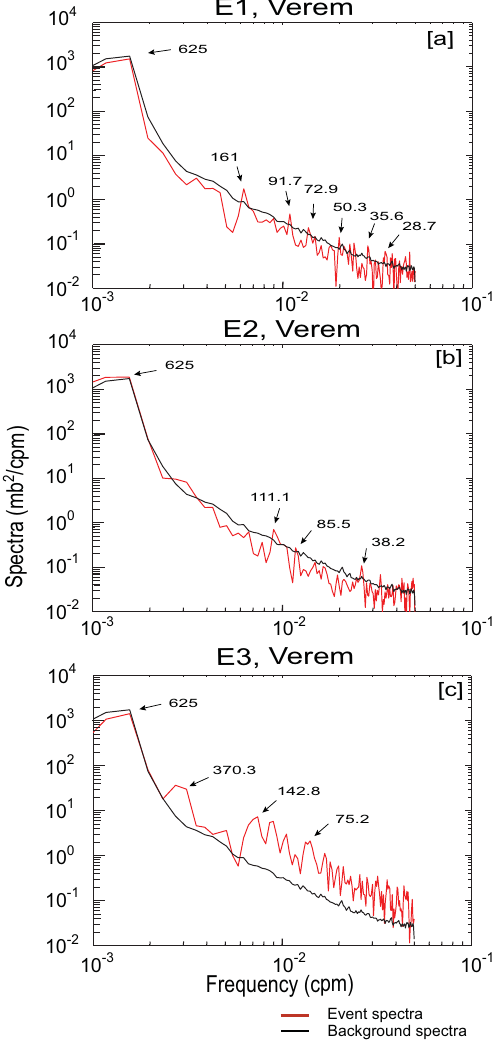
Fig. 7. Atmospheric pressure anomaly spectra during differ- ent events (red) along with the corresponding background spectra (black) at Verem (a) E1 over 3 days (Julian days 174–176, N = 432) (b) E2 over 3 days (Julian days 255–257, N = 432) and (c) E3 over 4 days (Julian days 313–316, N = 576). N represents the number of data samples used in estimating the spectra. The number associated with significant peaks is time period in